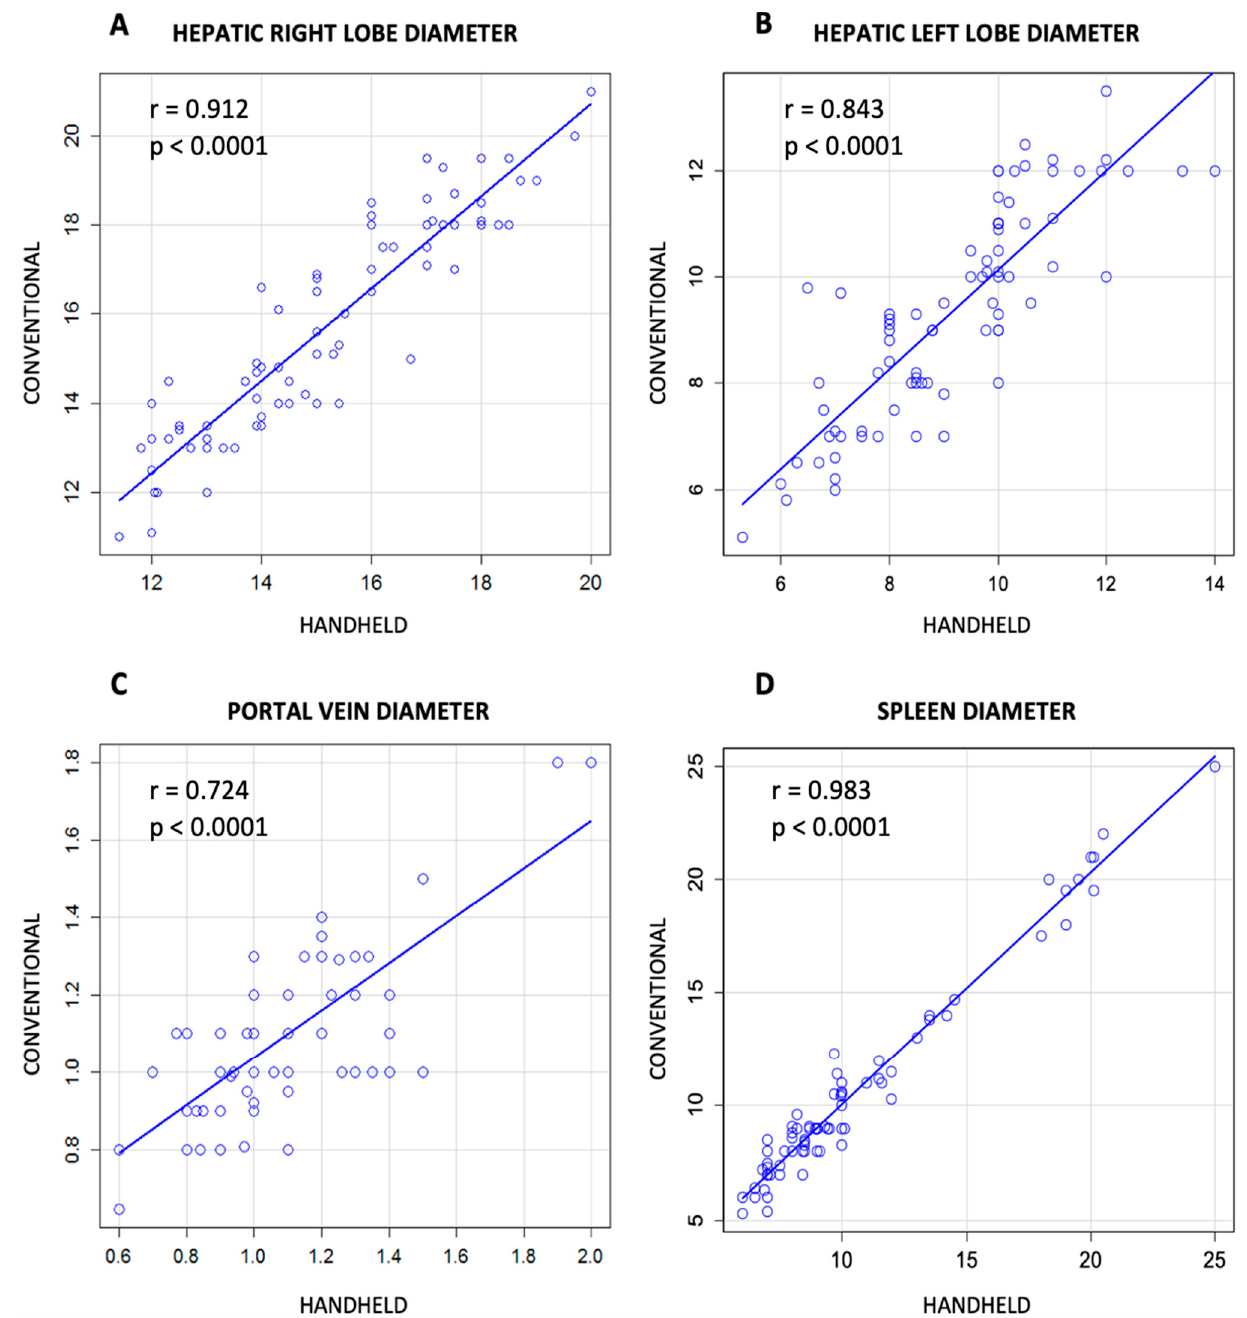
Figure 2. Correlation between results obtained with handheld and conventional ultrasound in meas- urement of diameter of liver (figures 2A and 2B for right and left hepatic lobe diameter, respec- measurement of diameter of liver (( A ) and ( B ) for right and left hepatic lobe diameter, respectively), tively), portal vein (figure 2C), and spleen (figure 2D). portal vein ( C ), and spleen ( D